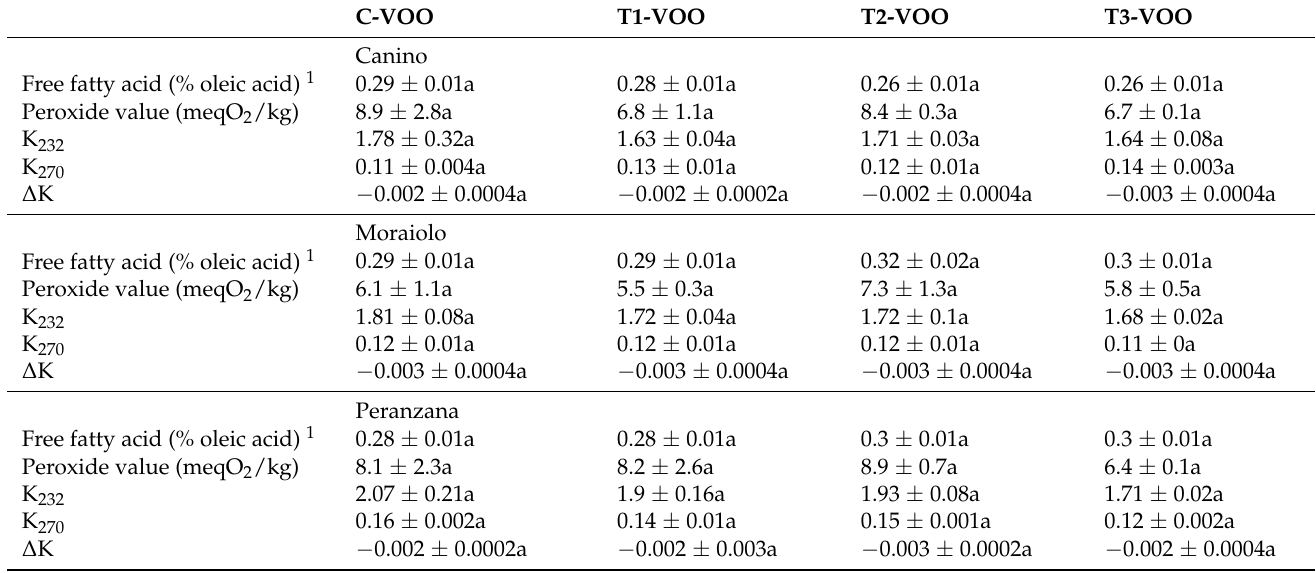
Table 1. Legal quality parameters of VOOs extracted at different processing